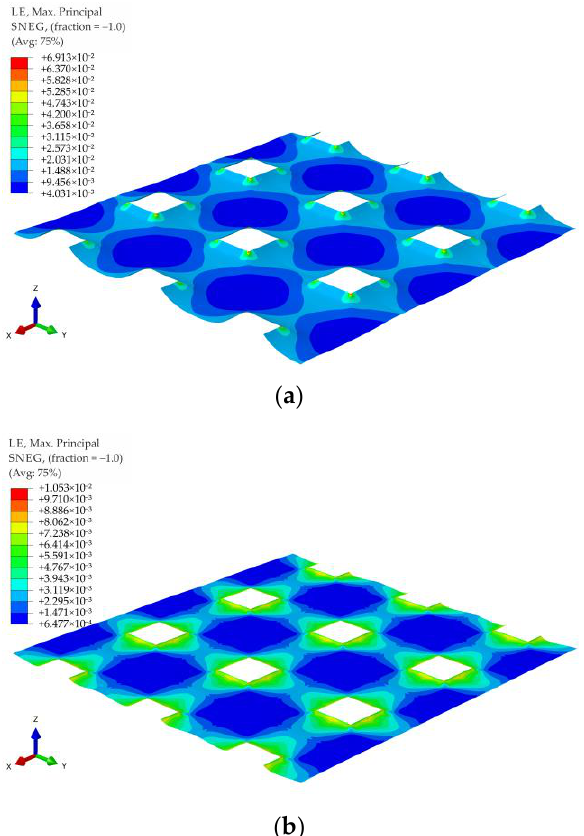
Figure 28. Deformation and maximum principal strain in reinforcement for inverse pyramid shape load distribution, variant A1: ( a ) k = 0 kN/m 3 ; ( b ) k = 500 kN/m 3 .